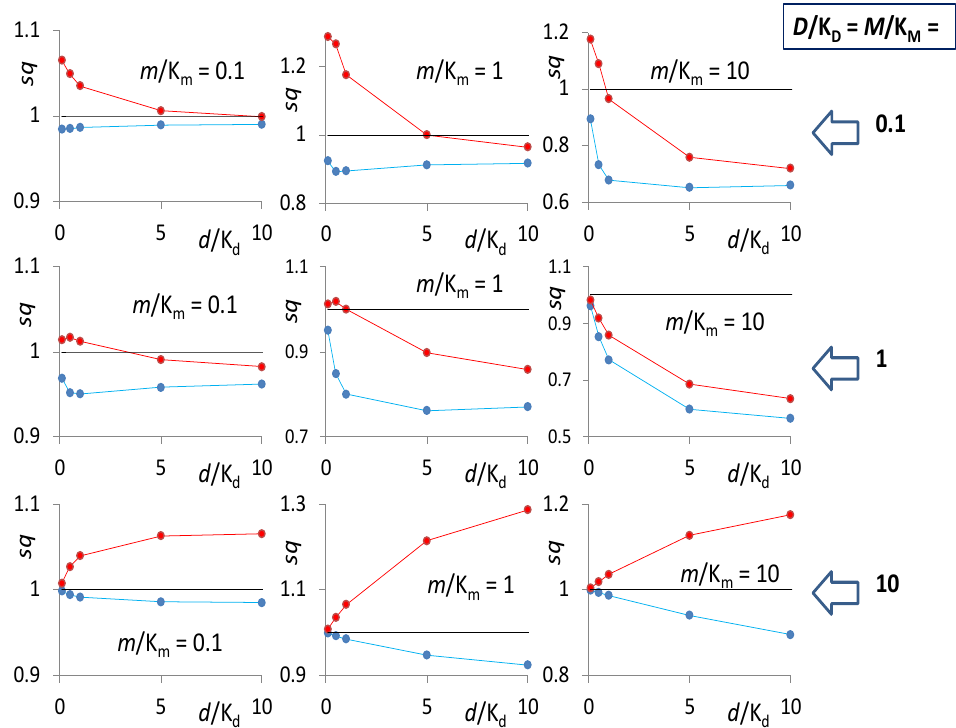
Figure 5. Synergism quotients ( sq ) calculated for the kinetic scheme in Figure 4a in the cases of simultaneous binding of the two inhibitors (m and d, red symbols) and in the case of mutual exclusivity of the inhibitors (blue symbols) for several choices of i /K i ratios (from the top, 0.1, 1, and 10). The black line separates the synergistic ( sq > 1) from the antagonistic values ( sq < 1).